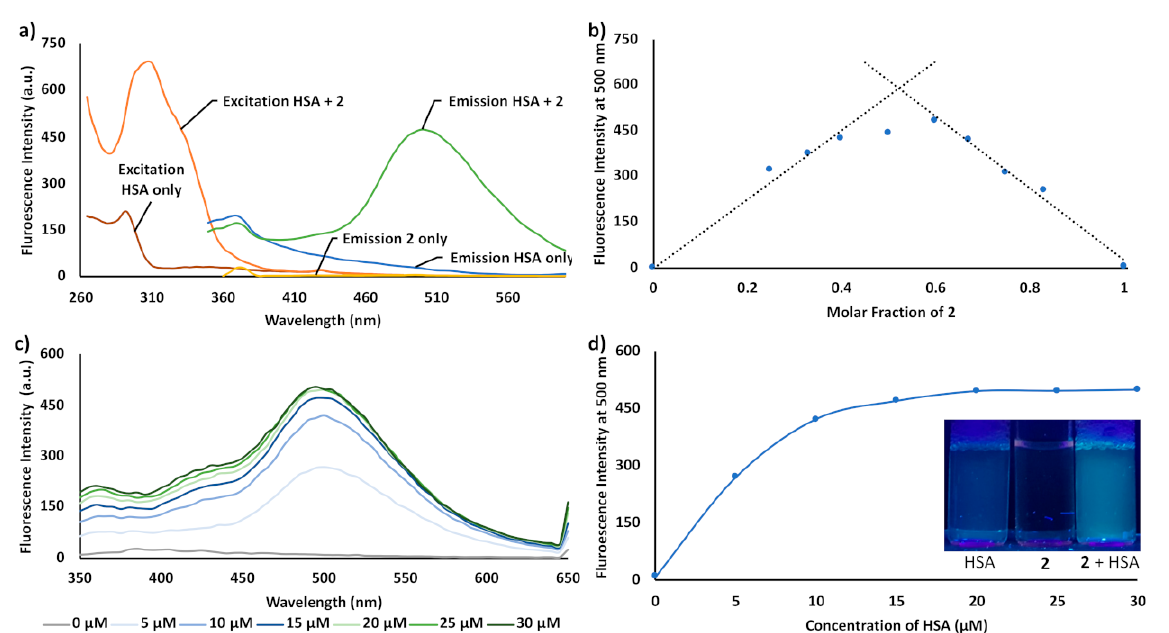
Figure 6. ( a ) Excitation and emission spectrum for solutions 10 µ M in 2 , 20 µ M in human serum albumin (HSA), and their combination, respectively, in deionized water. ( b ) Job plot of 2 and HSA with the sum of both species = 30 µ M in deionized water. ( c ) Addition of human serum albumin (HSA) to a 10 µ M solution of 2 in deionized water. ( d ) Fluorescence intensity at 500 nm plotted against [HSA]. In the photo, the fluorescent emission of 25 µ M HSA, 25 µ M 2 and both combined is shown under excitation at 350 nm using a hand-held UV lamp. Emission spectra were collected with excitation at 330 nm and excitation spectra were collected for the emission at 500 nm. All experiments were conducted using excitation and emission slit widths of 5 nm, respectively. The quantum yield of 2 after complexation with two equivalents HSA was calculated to be 0.0272 (reference: quinine sulfate, 0.1 M H 2 SO 4 ), which is in agreement with other deferasirox derivatives that we have reported previously